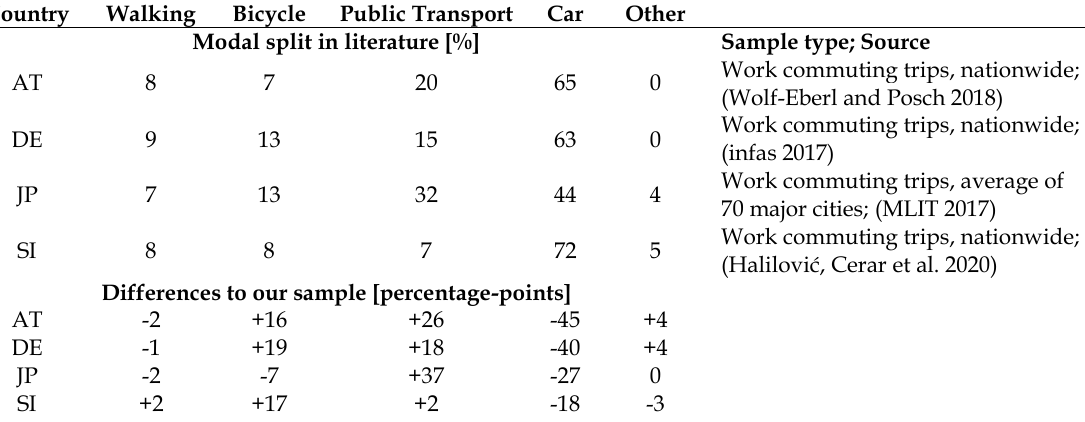
Comparison of modal split in national transport surveys to our